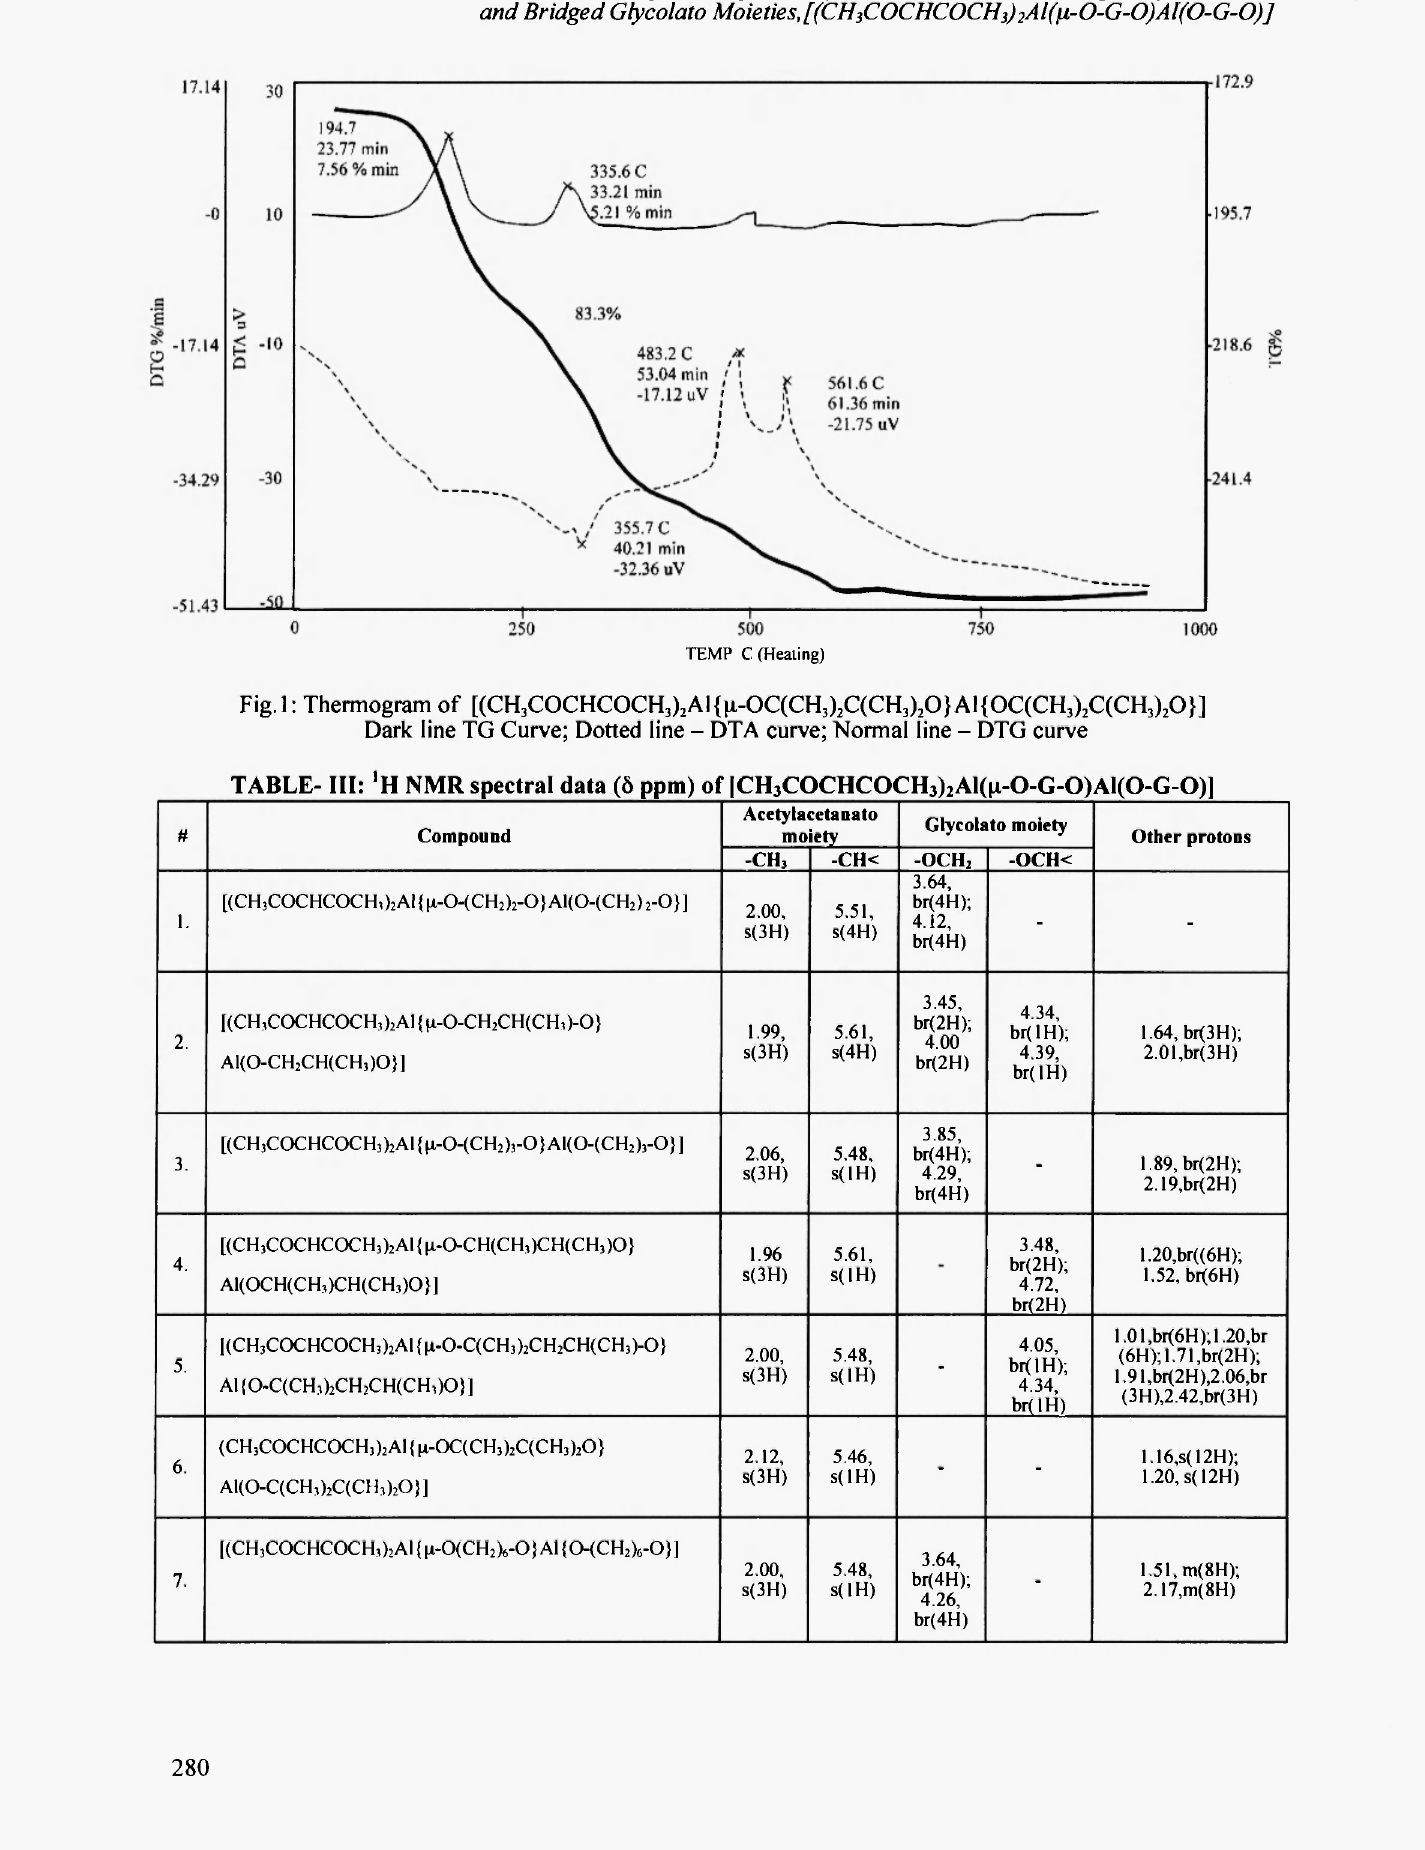
Fig. 1: Thermogram of [ ( € Η 3 € Ο 0 Ή € Ο € Η , ) 2 Α Ι { μ - Ο € ( 0 Η , ) 2 α 0 Η 3 ) 2 Ο}